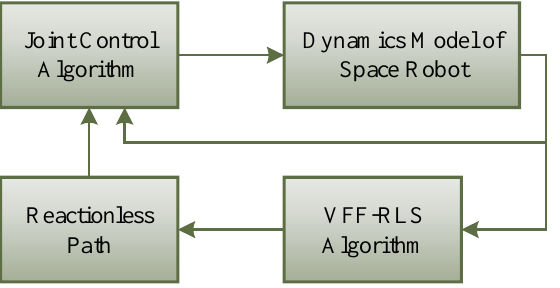
Figure 2. The Adaptive Reaction Null Space (ARNS) path planning algorithm flow diagram.